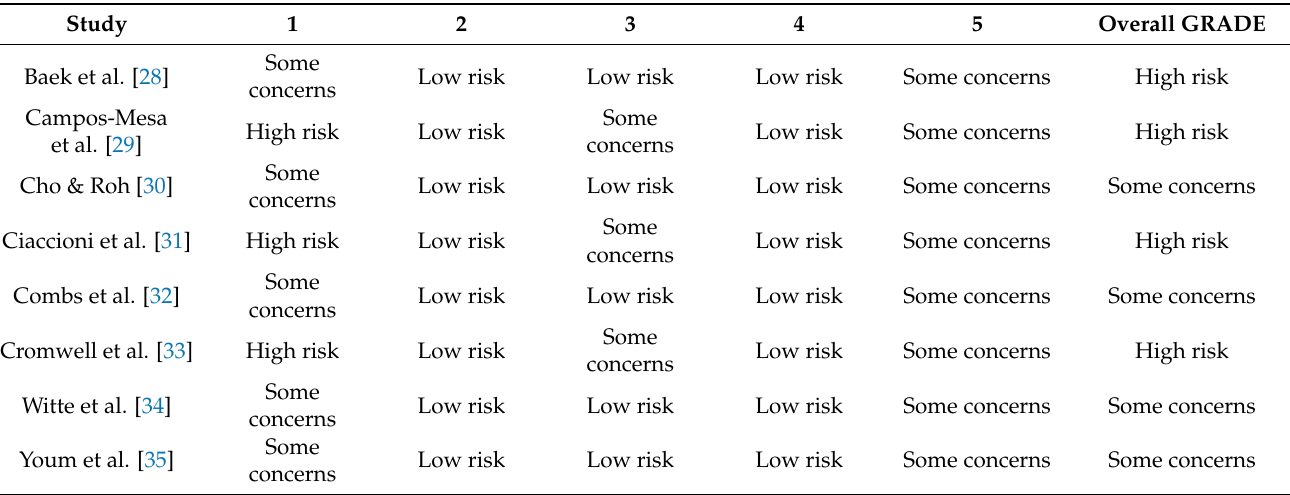
Table 3. Risk of bias within